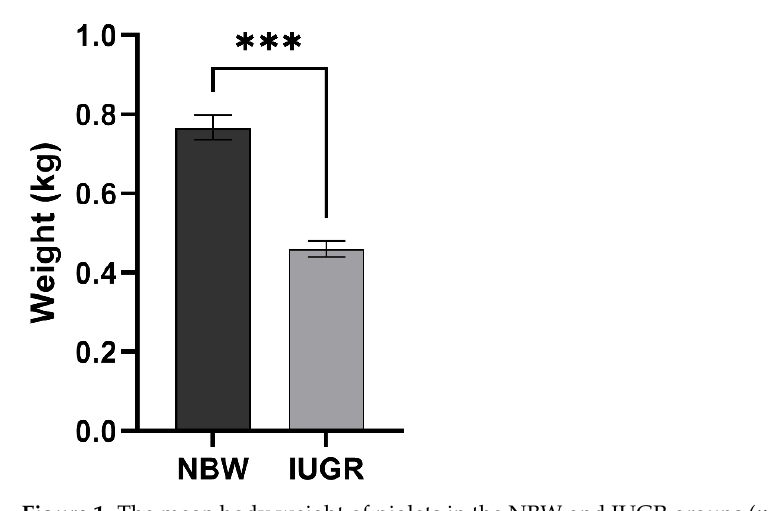
Figure 1. The mean body weight of piglets in the NBW and IUGR groups ( n = 3). Data are shown as mean ± standard deviation (SD), “***” indicates significant differences ( p < 0.001).